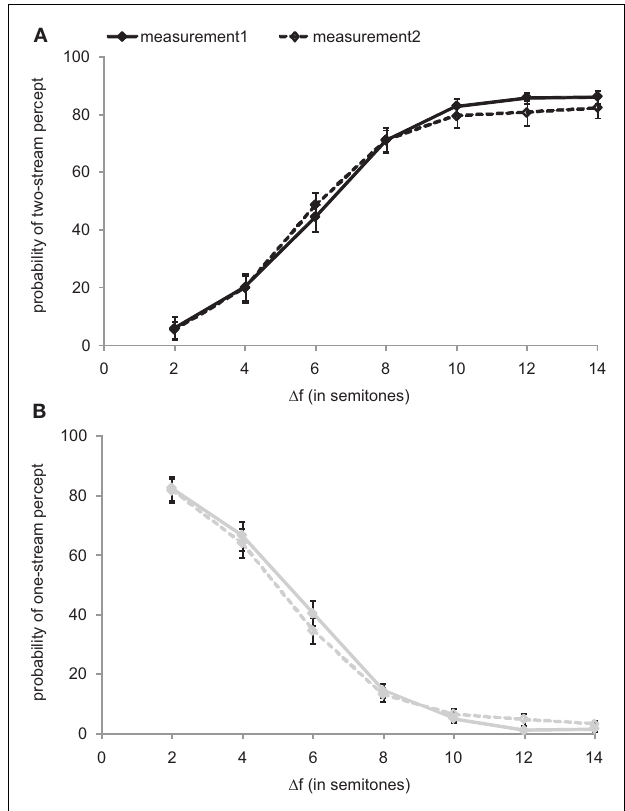
FIGURE 1 |Test-retest reliability. The psychometric functions from the first (solid line, filled symbols) and the second measurement (dashed line, open symbols) represent the proportions of time that the stimulus sequences were perceived as two streams (A) and as one stream (B) , as functions of the frequency separation, ∆ f , between A and B sounds (expressed as semitones). Symbols and error bars represent means and SEM.The proportions depend on ∆ f , but do not differ between the two